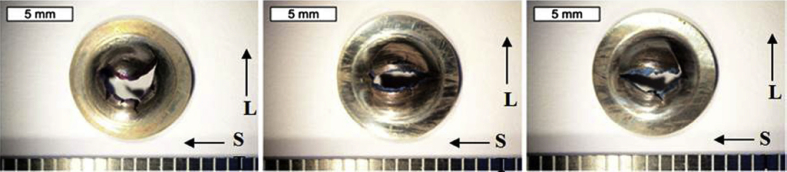
Examples of ALM small punch test specimens following the small punch test. From Hurst et al. [2016].39